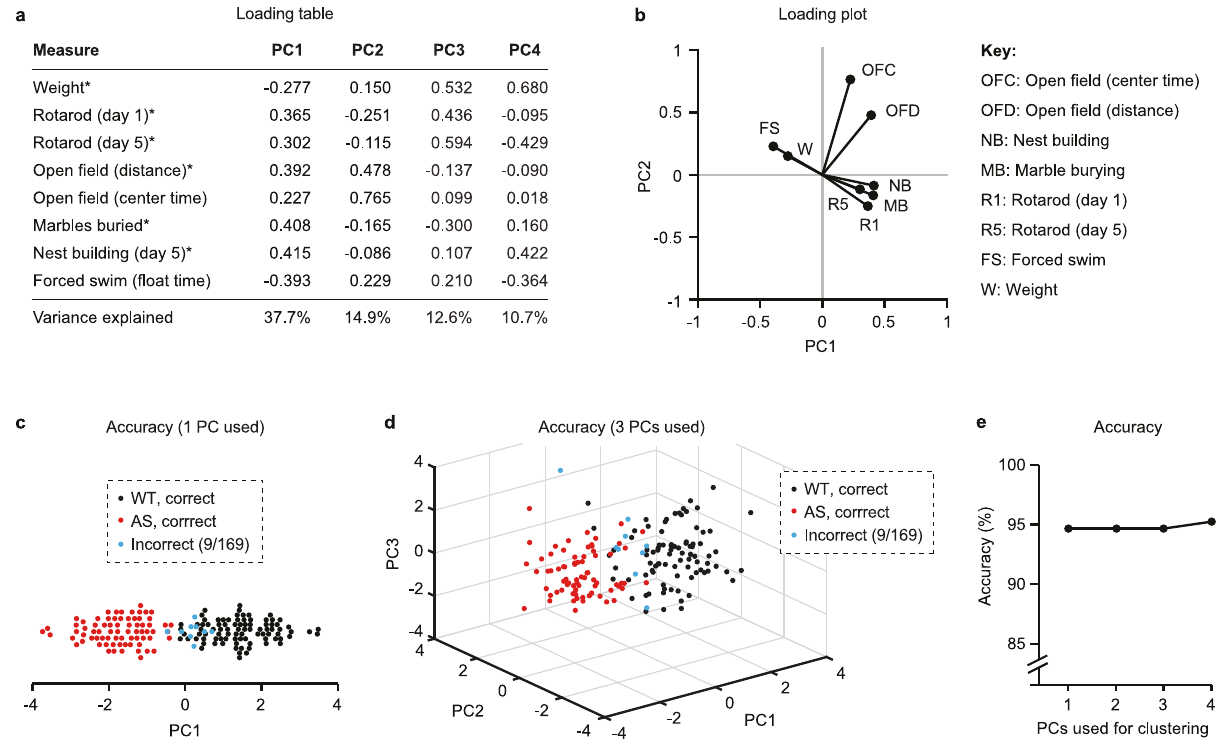
Fig. 5 Principal component 1 (PC1) is suf fi cient for predicting Ube3a genotype with high accuracy. a Loadings for PC1 – PC4 for each behavioral measure. b Loadings for PC1 and PC2 for each measure, plotted in 2PC space. All behavioral measures except open fi eld correlate more strongly with PC1, and both open fi eld measures correlate more strongly with PC2. c Clustering accuracy using 1 PC is 94.7%. d Clustering accuracy using 3 PCs is 94.7%. e Increasing the number of PCs used for clustering does not have a major impact on clustering accuracy.